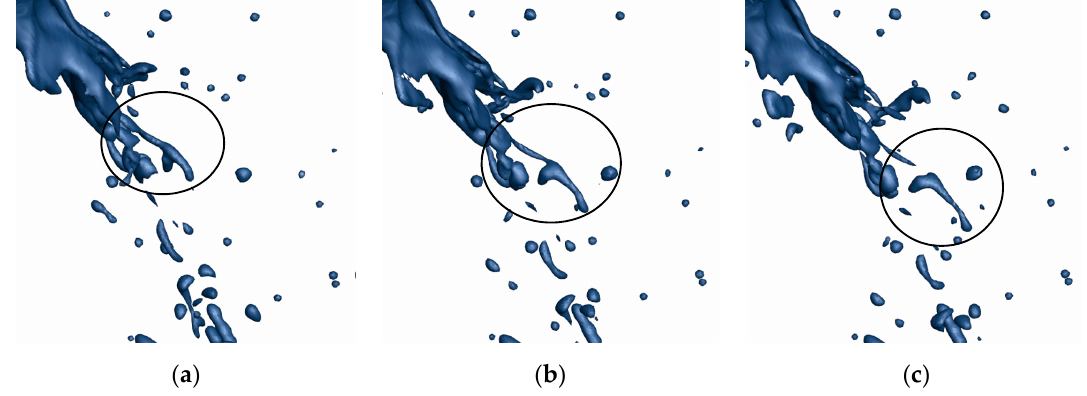
Figure 13. Formation process of paint micelles: ( a ) 2.066 ms, ( b ) 2.077 ms, and ( c ) 2.084 ms.